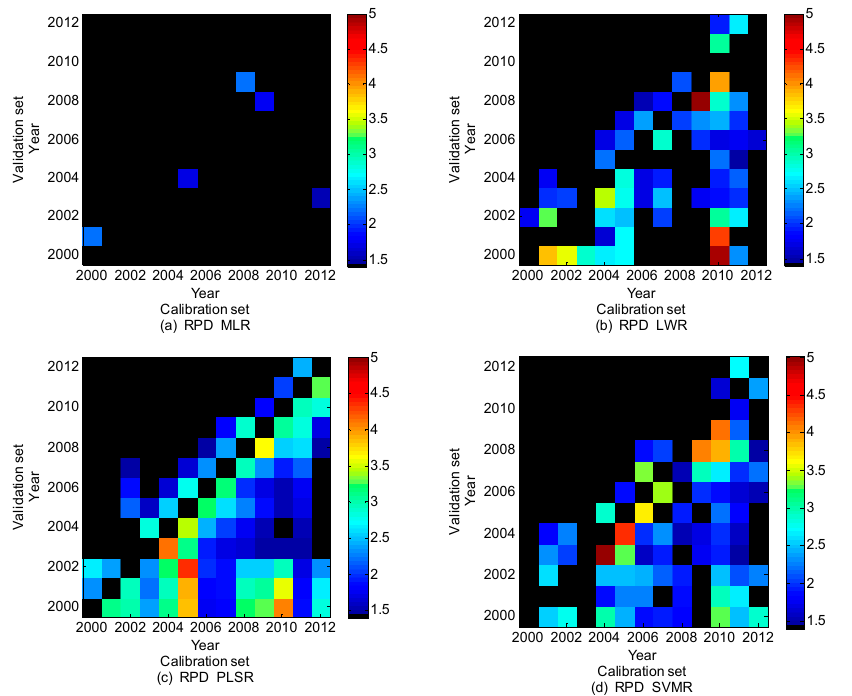
Figure 5. RPD for different data mining methods in validation across years: ( a ) MLR; ( b ) LWR; ( c ) PLSR and ( d ) SVMR.